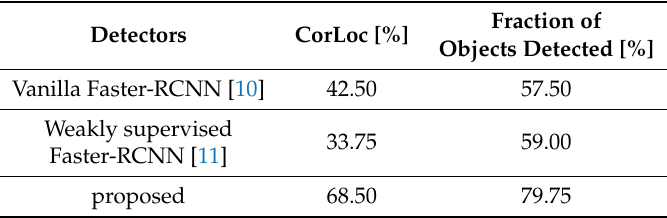
Table 4. Results for various object detectors.